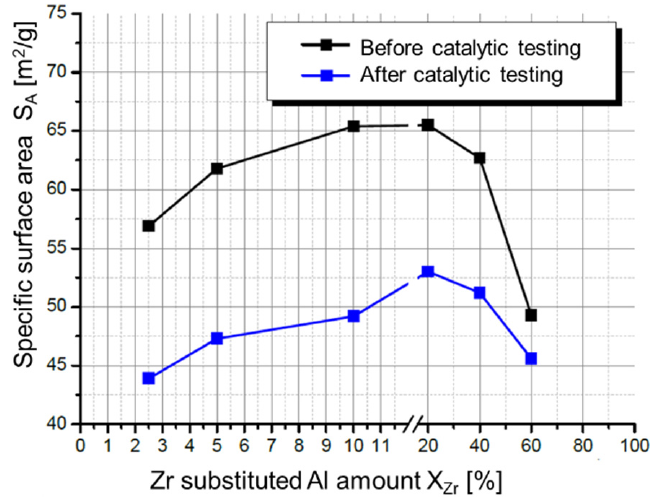
Figure 18. Specific surface areas before and after the catalytic testing depending on the amount of zirconium substituting Al. Catalyst system: Cu 0.61 Zn 0.21 Al 0.18-(0.18 · xZr) Zr (0.18 · xZr) , h equ = 600, T calc = 873 K, t calc = 2 h, heating rate =1 K · min − 1 .